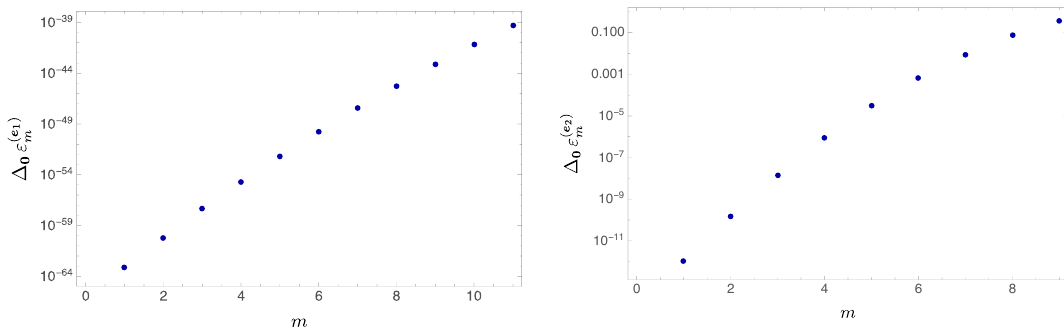
Figure 4 . Comparison of the predicted results from resurgence techniques and the numerical ones obtained from solving Einstein equations. In the above plots we show this comparison for the coe(cid:14)cients of the fundamental sectors (cid:8) e